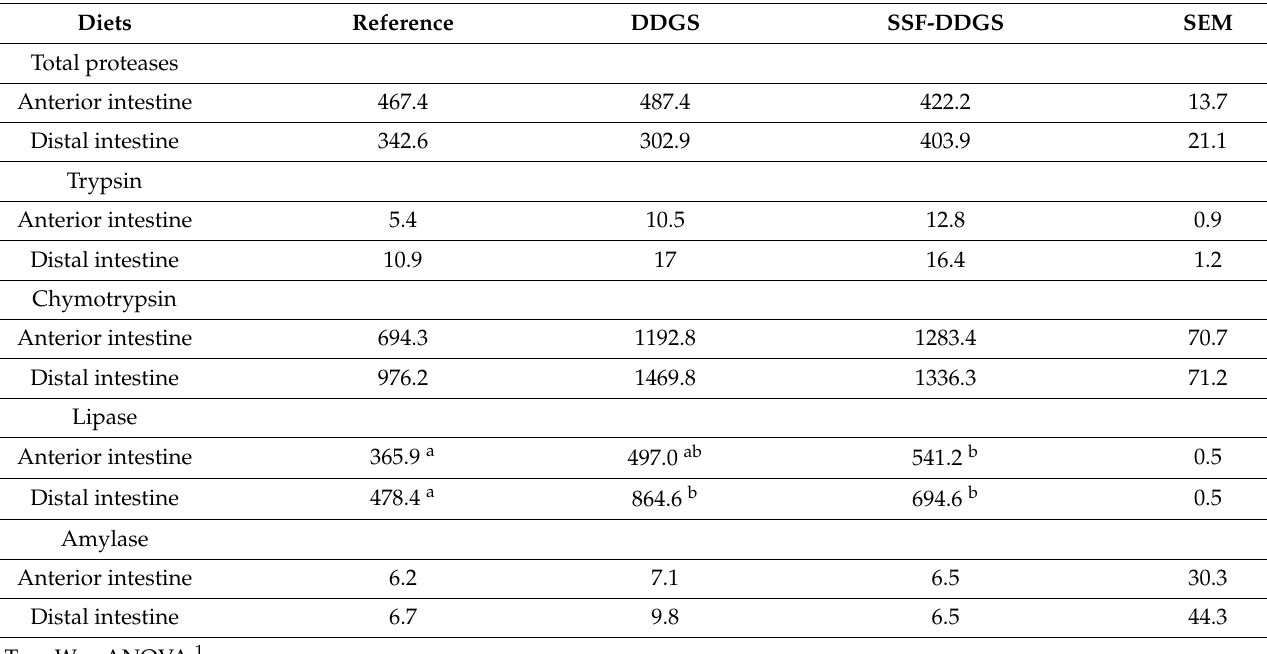
Table 6. Specific activity of protease, trypsin, chymotrypsin, lipase, and amylase (mU/mg protein) in anterior and distal intestine sections of European seabass fed the experimental